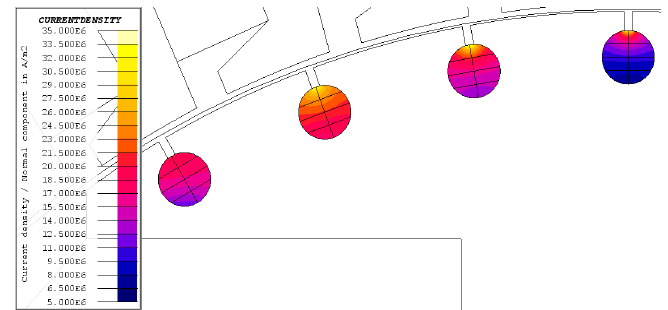
Figure 6. Damper bar segments and current distribution in the damper bar at 0.01 s after the short circuit by time-stepping FE simulation.